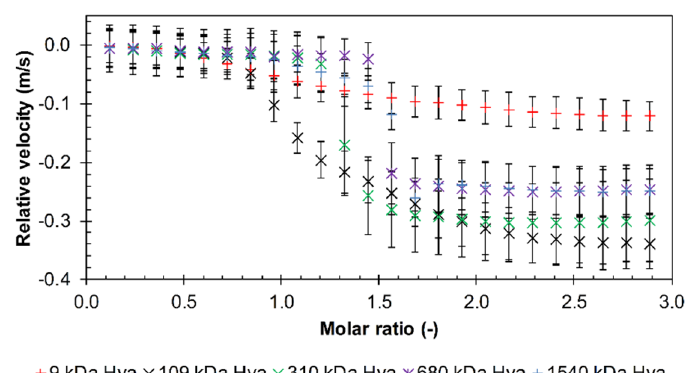
Figure 3. The relative ultrasonic velocity in dependence on the molar ratio for titrations of arginine triacontamer in hydrochloride form into hyaluronan of different molecular weights in PBS (11.6 MHz, 25 °C).